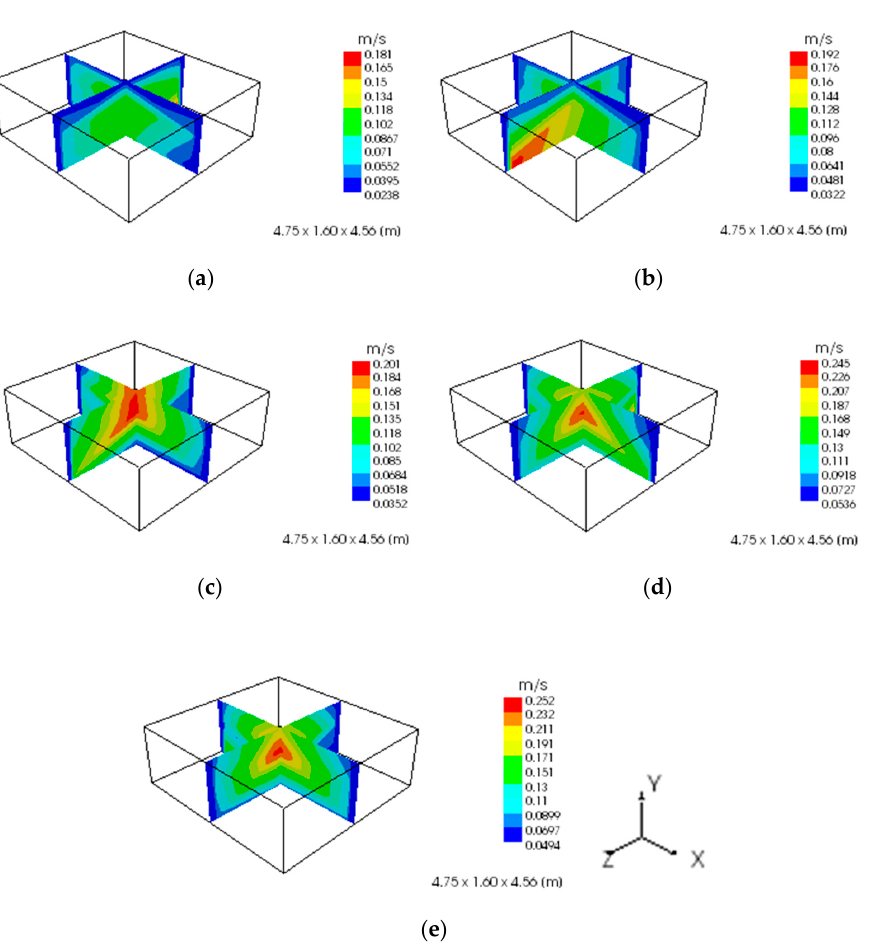
Figure 10. Velocity profiles of air flow in the experimental laboratory for individual variants; ( a ) Variant 1; ( b ) Variant 2; ( c ) Variant 3; ( d ) Variant 4; ( e ) Variant 5.